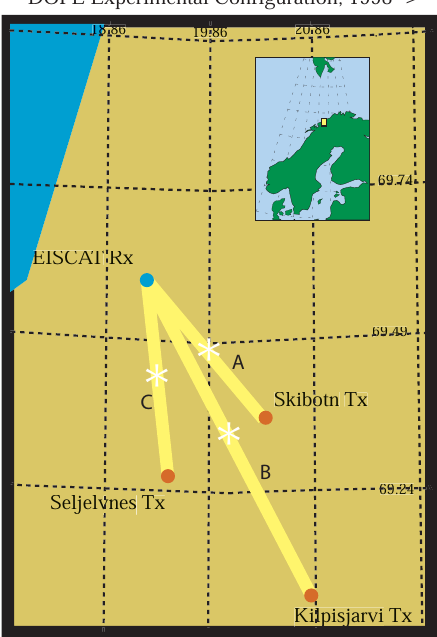
Fig. 1. A schematic of the DOPE (Doppler Pulsation Experiment) HF sounder located in northern Scandinavia. The three beam paths are marked as A, B and